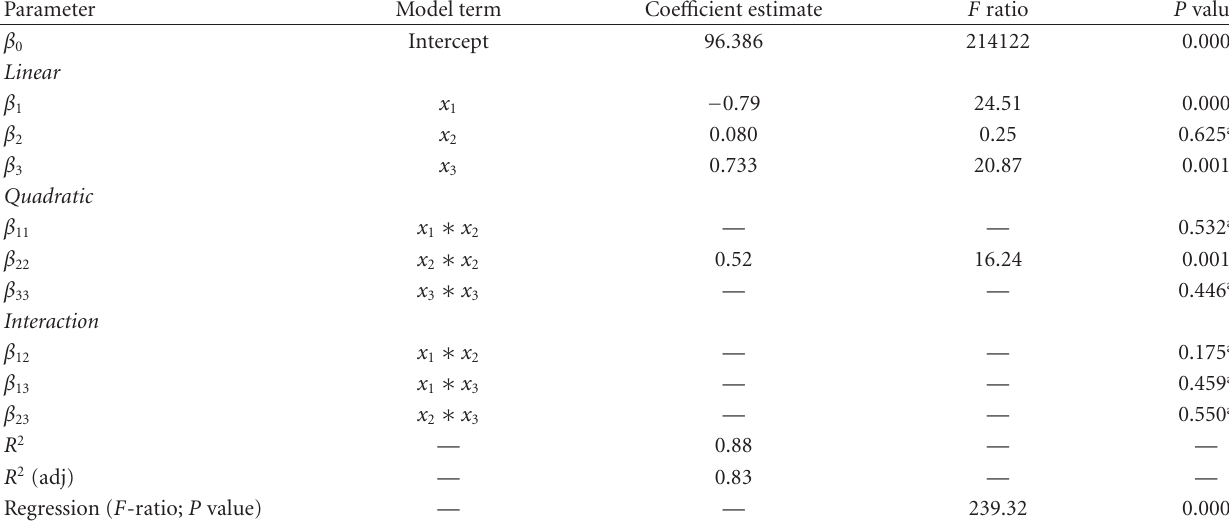
Table 3: The regression coe ffi cients ( R 2 ), adjusted R 2 , F ratio and P value of the final reduced